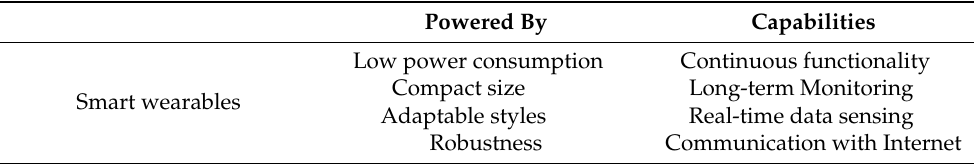
Table 1. Success reasons and success points of smart